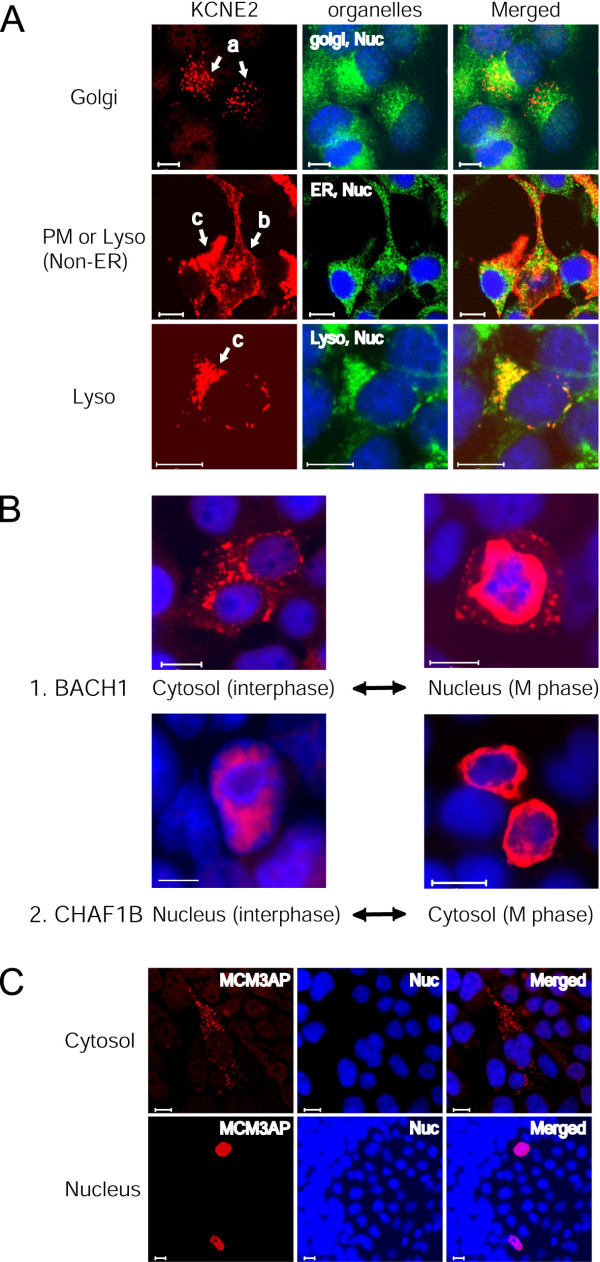
Protein intracellular translocation observed on cell arrays. (A) Stages of post-translational trafficking of KCNE2, a plasma membrane (PM) protein, including the early modification within the Golgi complex (a) and final localization at the PM (b) or in the lysosomes (c), without retention in the ER. (B) Translocation of BACH1 and CHAF1B proteins during cell interphase and mitosis. 1. BACH1 proteins distributed in the entire cytosol at interphase. In early mitosis, most proteins accumulated in the nucleus and wrapped around condensed chromosome. 2. During the interphase, CHAF1B protein localized in the nucleus, whereas after cell division it was found in the cytoplasm of two daughter cells. (C) Differential localization patterns of MCM3AP protein in the cytoplasm and nucleus. The scale bar represents 10 μm.